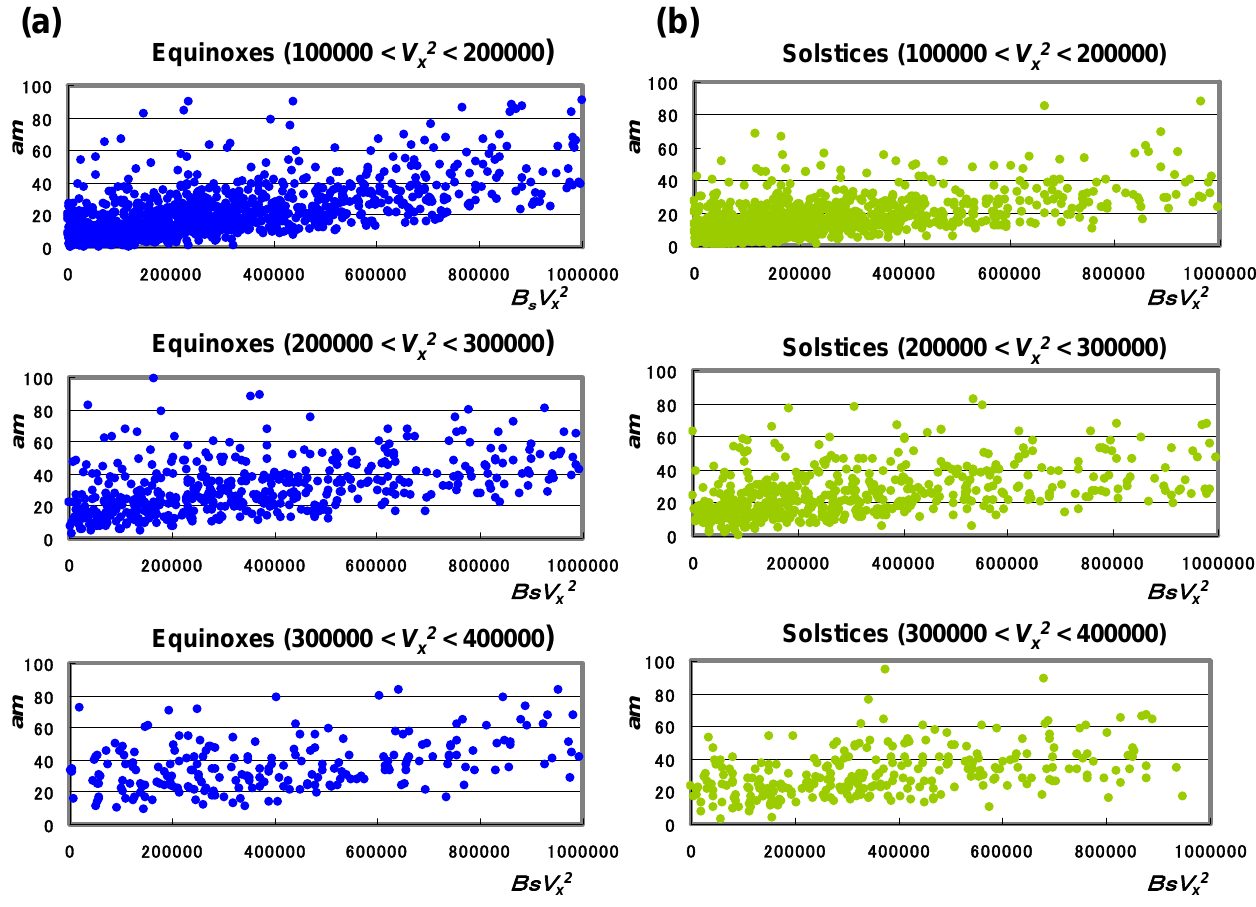
Fig. 1. Plot of geomagnetic am index versus B s V 2 x (GSM) for 1998–2007 in velocity ranges of (upper) 100000 <V 2 x < 200000, (middle) 200000 <V 2 x < 300000, and (lower) 300000 <V 2 x < 400000, where V x is the solar wind velocity in the sun-earth direction in km/s and B s is the magnitude of the southward component of the IMF in nT. (a ) Equinoctial epochs ( ± 15 days from equinoxes). (b) Solstitial epochs ( ± 15 days from